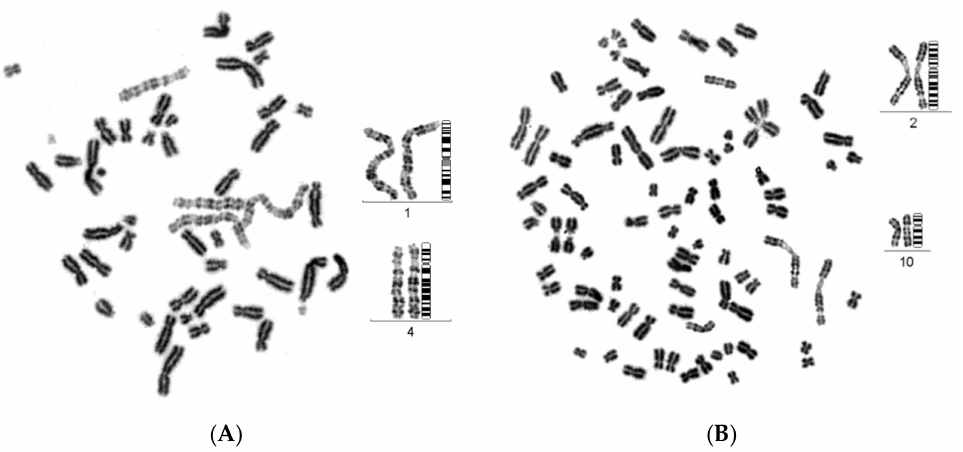
Figure 5. Normal DNA replication can take place in MN. Following radiation exposure of human lymphocytes to generate micronucleated cells, anaphase lagging chromosomes entrapped in MN can undergo chromatid disjunction and complete DNA replication, without any shattering or impairment in their duplication, if entrance of main nuclei into mitosis is su ffi ciently delayed by RO-3306. ( A ) Duplication of chromosomes 1, 4 and a fragment entrapped in MN. ( B ) Duplication of chromosomes 2 and 10 entrapped in MN. Based on G-banding ideograms for chromosomes 1, 4, 2, and 10, there is no impairment in the duplication of these chromosomes entrapped in